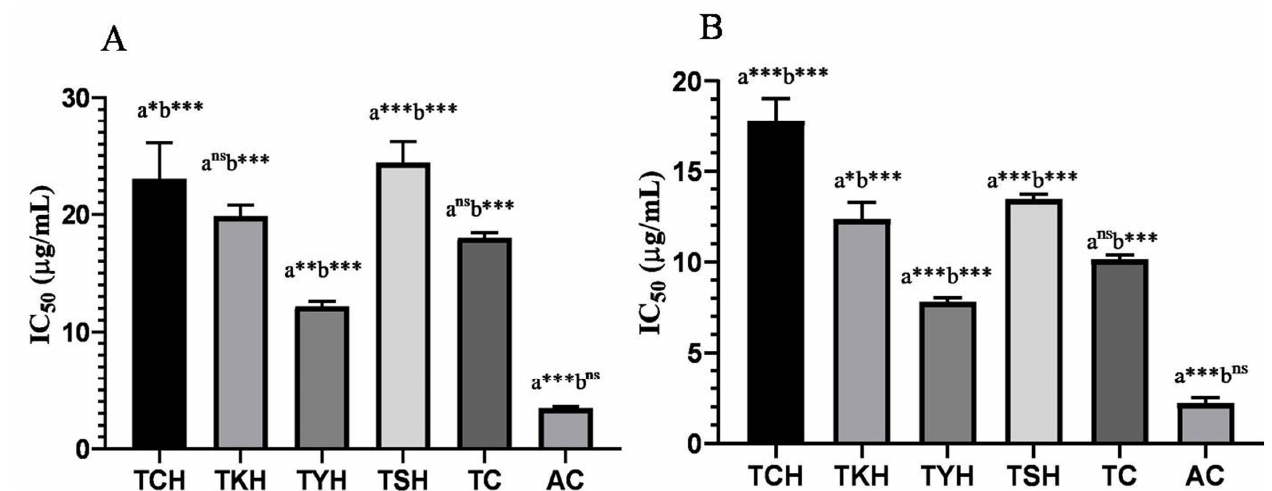
Figure 2. Antioxidant activity of T. chebula extracts from different locations in Manipur., standards Trolox (TC) and ascorbic acid (AC) as determined by ( A ) DPPH assay and ( B ) ABTS assay. Values represent mean ± SD of three independent experiments. Statistical significance was set at p < 0.05.